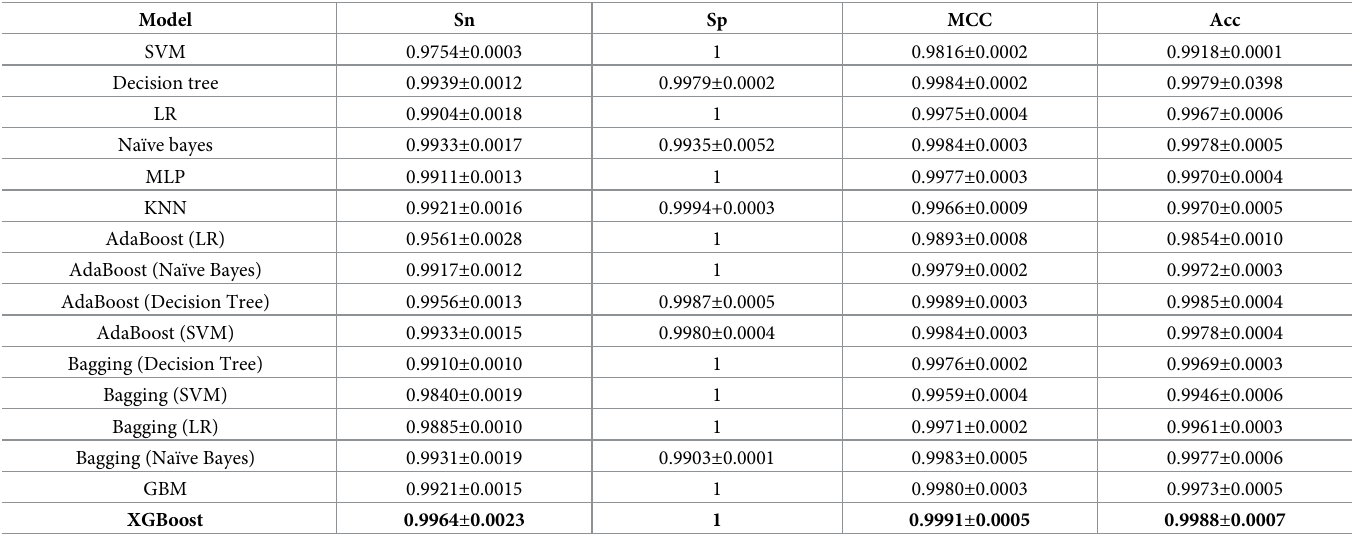
Table 6. Display of all model classification results.